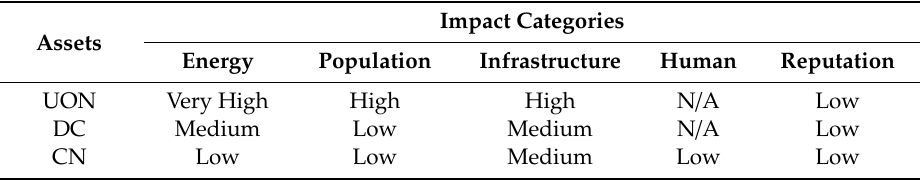
Table 1. Impact Levels for SMiShing Attack.